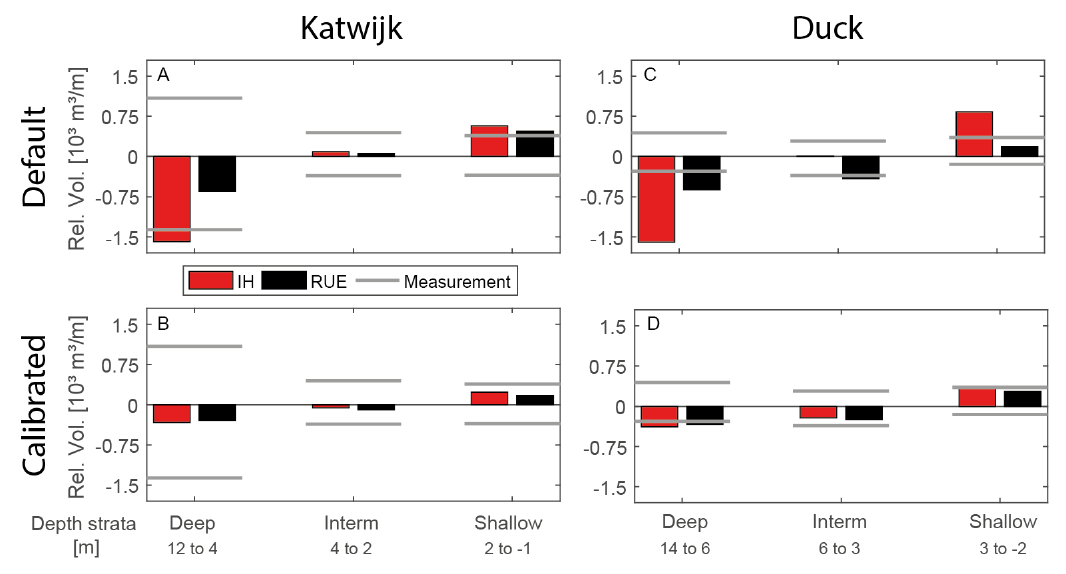
Figure 11. Profile volume after 10 years relative to the initial profile divided in depth zones. Positive values show deposition. Pannels ( A , B ) (left) are results from Katwijk and ( C , D ) (right) from Duck; ( A , C ) (top) are results for default sediment transport and ( B , D ) (bottom) for calibrated scenarios. The gray lines represent the minimum and maximum measured volumes as a